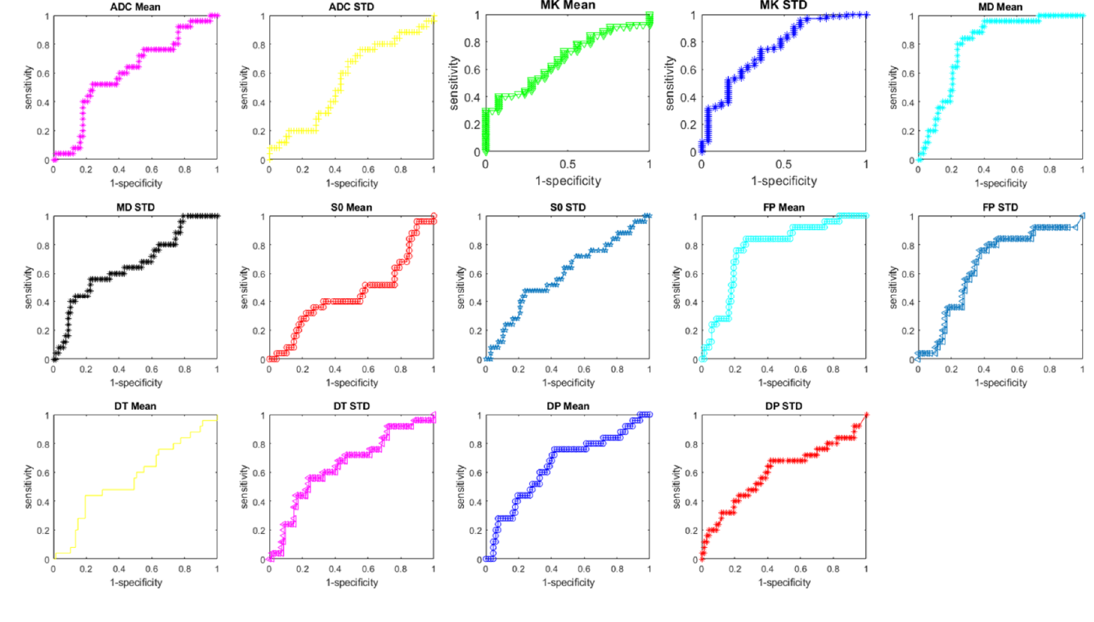
Figure 2. ROC curves of ADC-, IVIM- and DKI-derived parameters to differentiate presence/absence of RAS mutation.